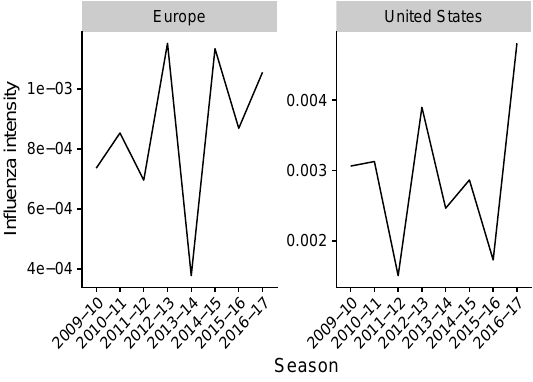
Figure A6. Seasonal influenza intensity in the United States and Europe. European influenza intensity is calculated as a average of country-level influenza intensity, weighted by population